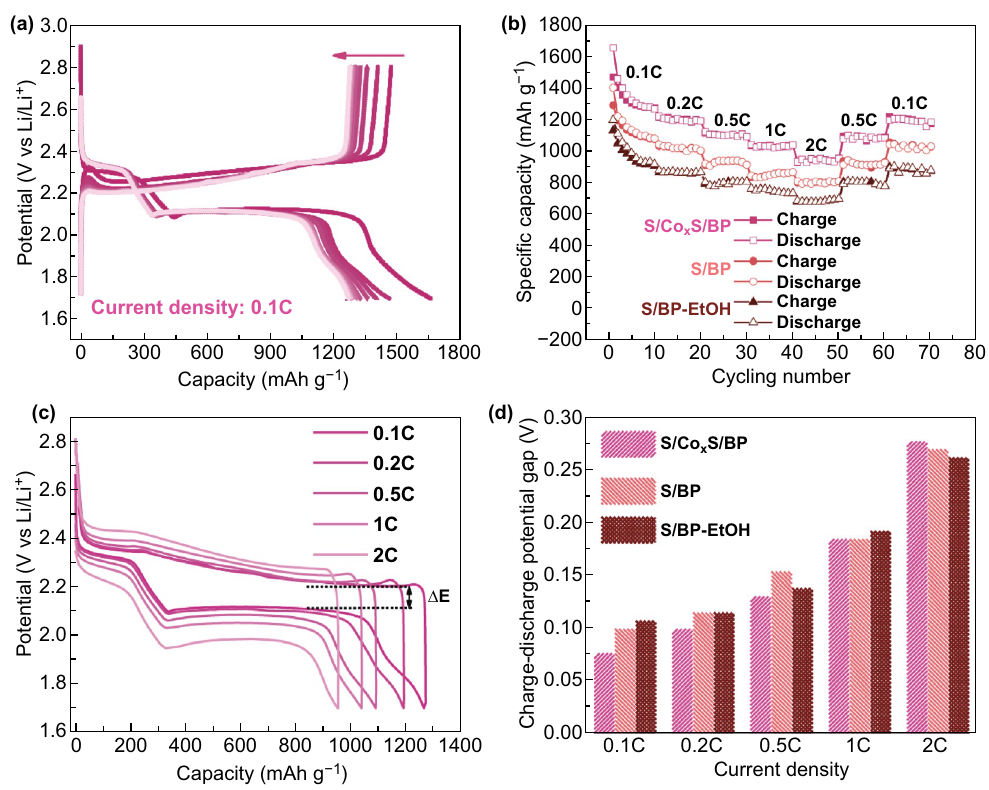
Fig. 5 a Discharge–charge profile of S/Co x S/BP at the rate of 0.1 C. b Rate capability of S/Co x S/BP compared with S/BP and S/BP-EtOH. c Discharge–charge profile of S/Co